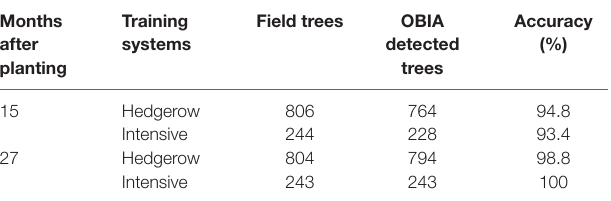
TABlE 2 | Accuracy attained by the OBIA algorithm in the olive tree detection. Months after planting